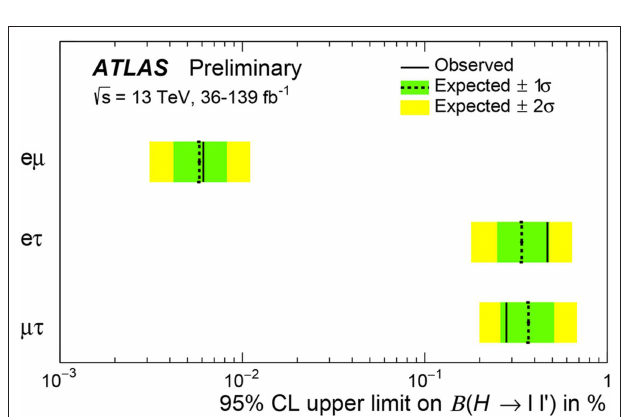
FIGURE 7 | Limits at 95% CL upper limits on the branching fractions of the Higgs boson to various lepton flavor violating decays in percent. The results for H e µ are from reference [50] and the H e τ and H µτ results are → → → taken from reference [49]. Expected limits are shown as a dashed line with the one- and two-sigma uncertainty bands in green and yellow. Reproduced from ATLAS Collaboration [50] under the Creative Commons CC-BY-4 license.